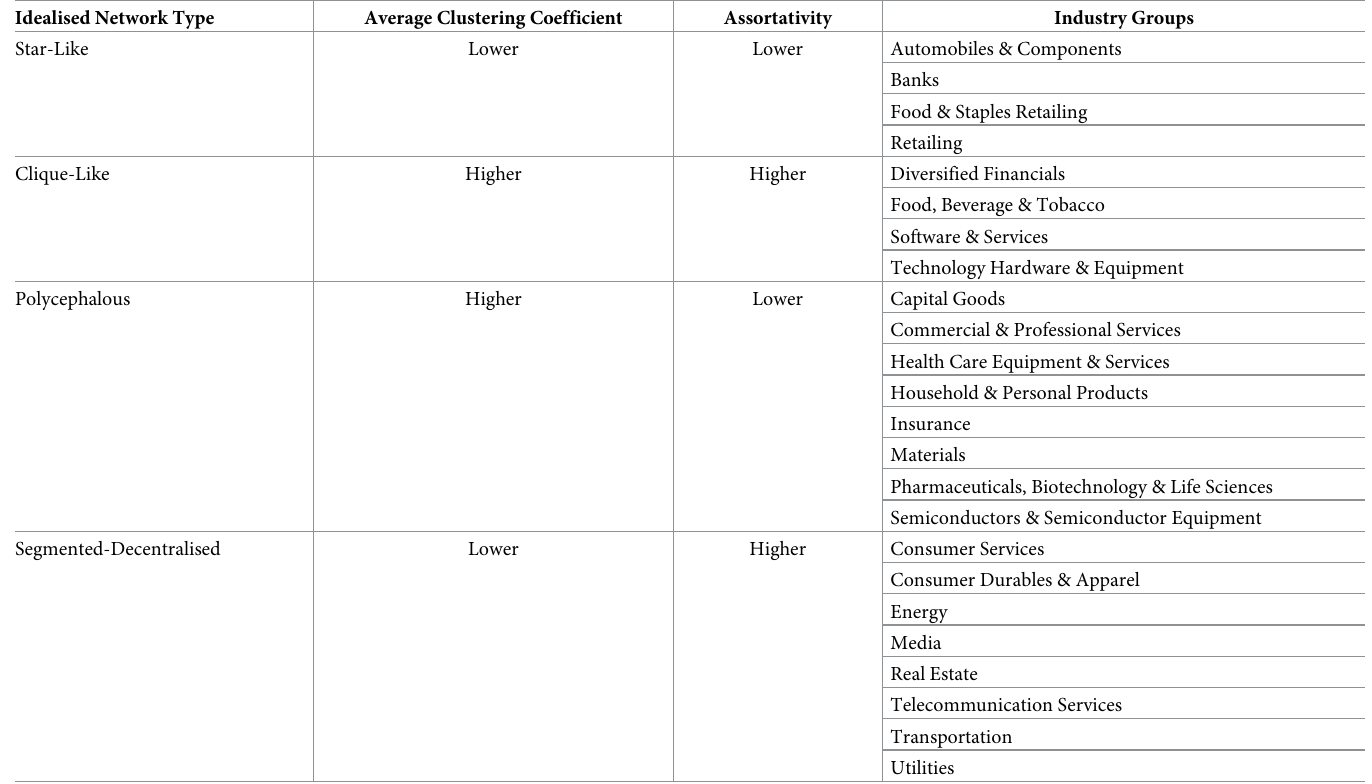
Table 3. Properties of four idealised network types in relation to median